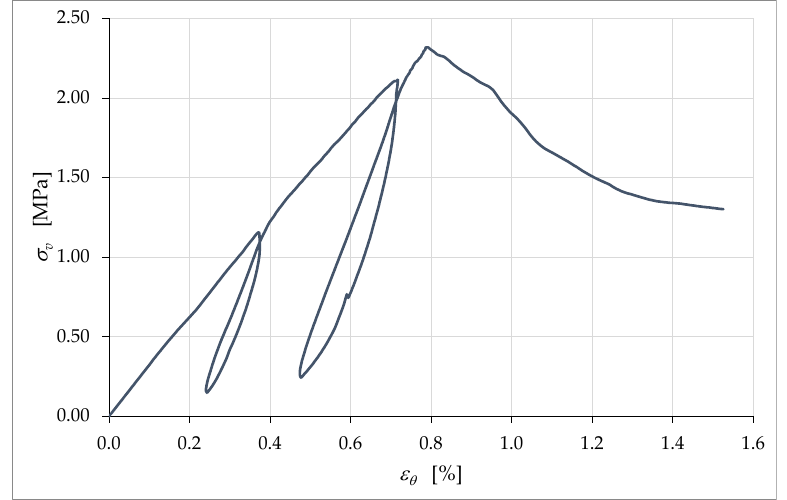
Figure 21. Curve of the axial stress, 𝜎 𝑣 , with respect to 𝜀 𝜗 (apparent volumetric strain).